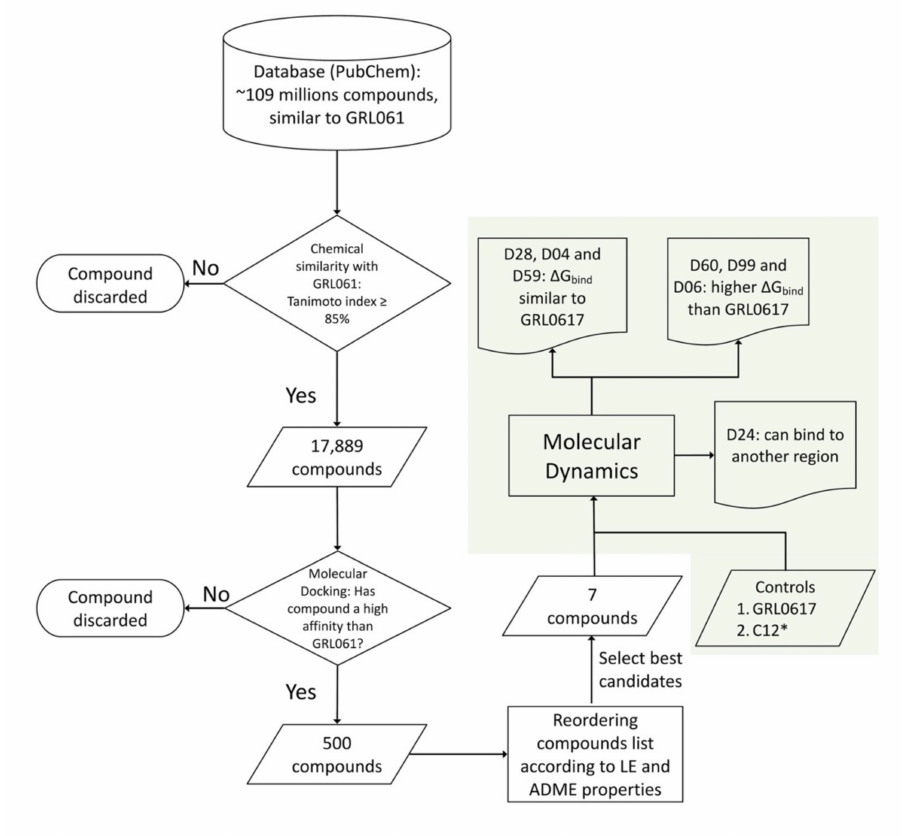
Figure 1. Diagram of the selection and evaluation of PLpro inhibitor compounds. Compound selection and evaluation process (green background). * PLpro inhibitor, in vitro tested, designed by chemical modification of GRL0617